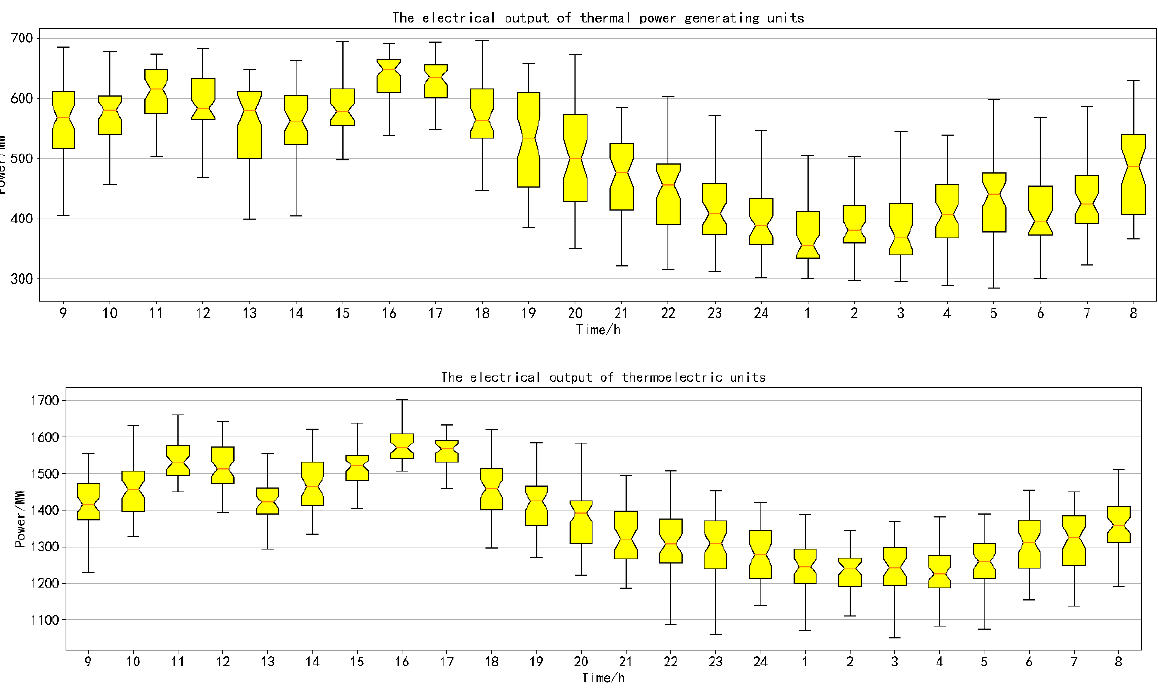
Figure 21. Box diagram of unit